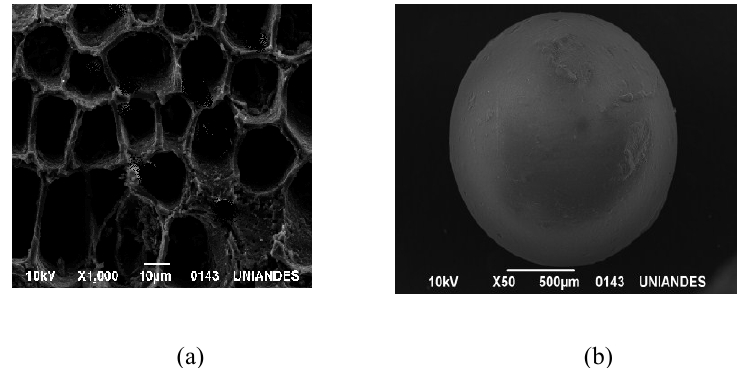
Figure 1. Monoliths obtained. a) Honeycomb type, b) Disc